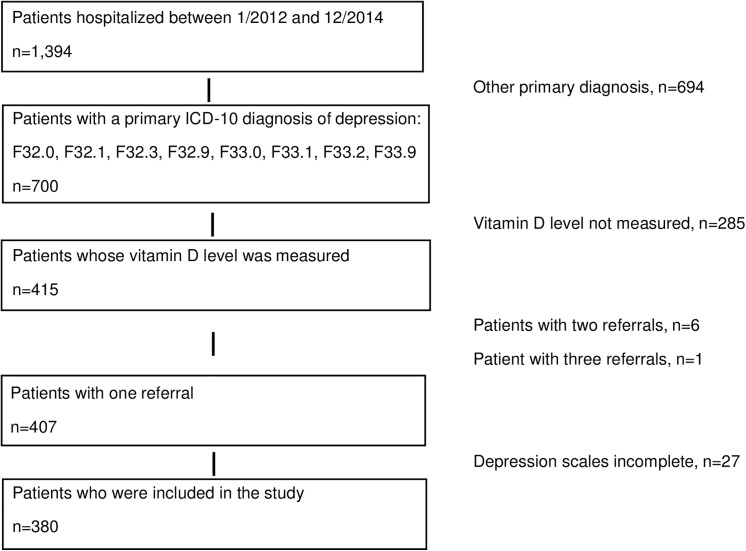
Flow chart of the included 380 patients with a depressive episode.